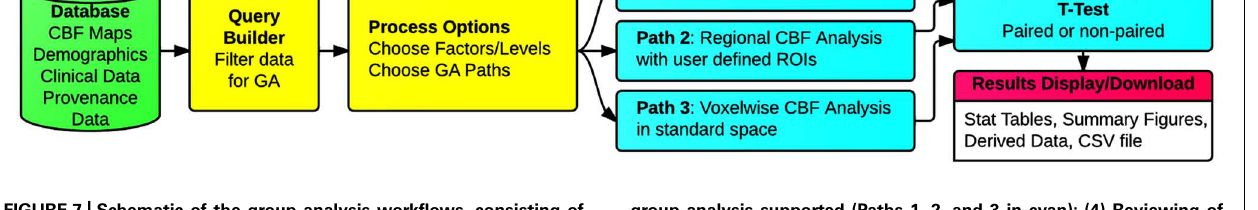
group analysis supported (Paths 1, 2, and 3 in cyan); (4) Reviewing of group analysis results ( n -way ANOVA/ t -test in cyan), (5) Reviewing and downloading processed results (Results Display/Download in